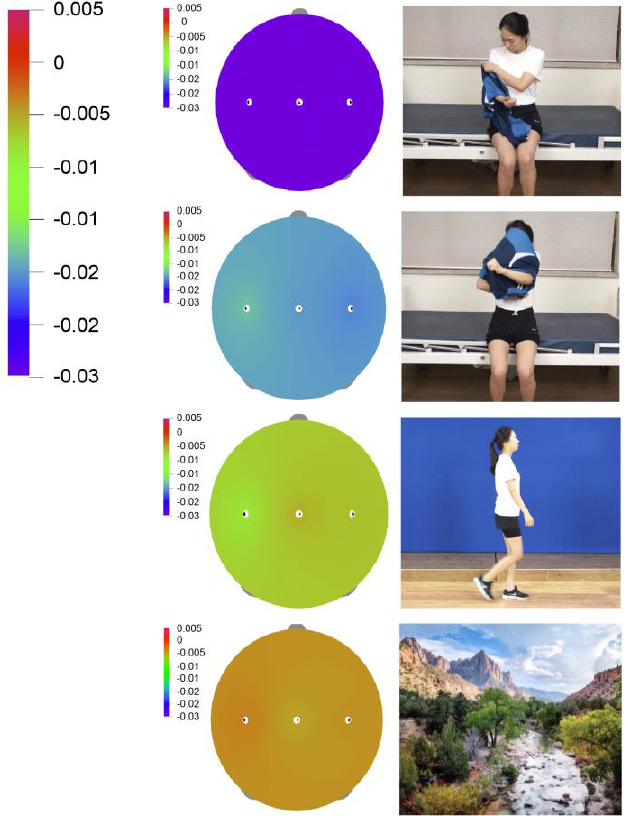
Figure 5. Mu rhythm mapping change. Electroencephalography (EEG)-based brain mapping indi- cated cortical activation during action observation training.